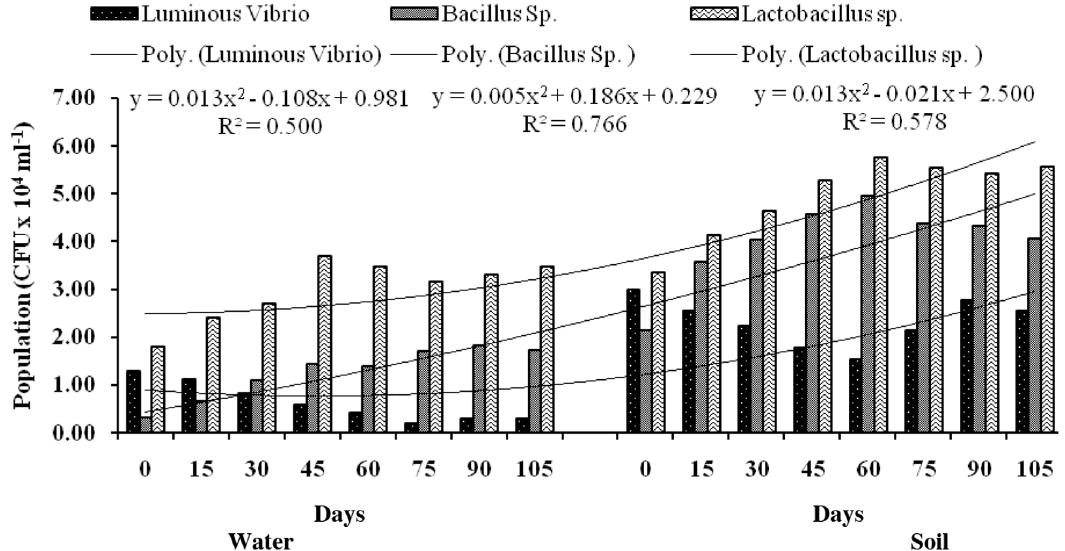
Fig. 2. Fitted relationship of cumulative changes in population of luminous Vibrio sp., Bacillus cereus , Lactobacillus sp. in without neem based bio fl oc culture system of L. vannamei .